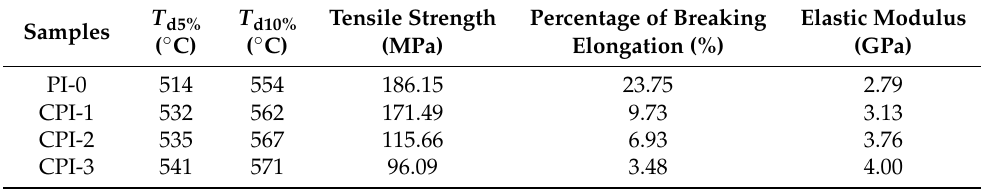
Table 1. Thermal and mechanical properties of the CPI